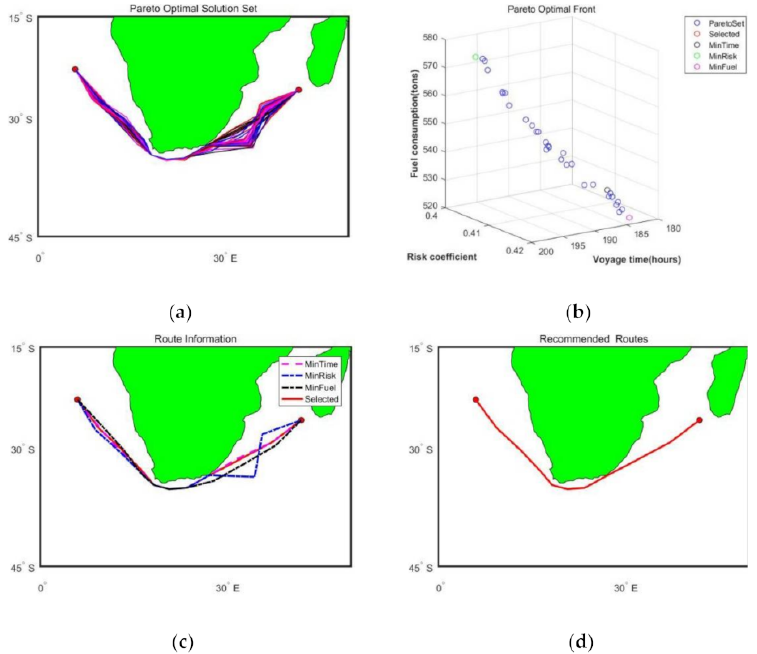
Figure 11. Ship route optimization results under complex offshore conditions: ( a ) the Pareto optimal solution set of the multicriteria route; ( b ) the Pareto optimal frontier solution; ( c ) great circle route and four optimized routes; and ( d ) recommended routes.